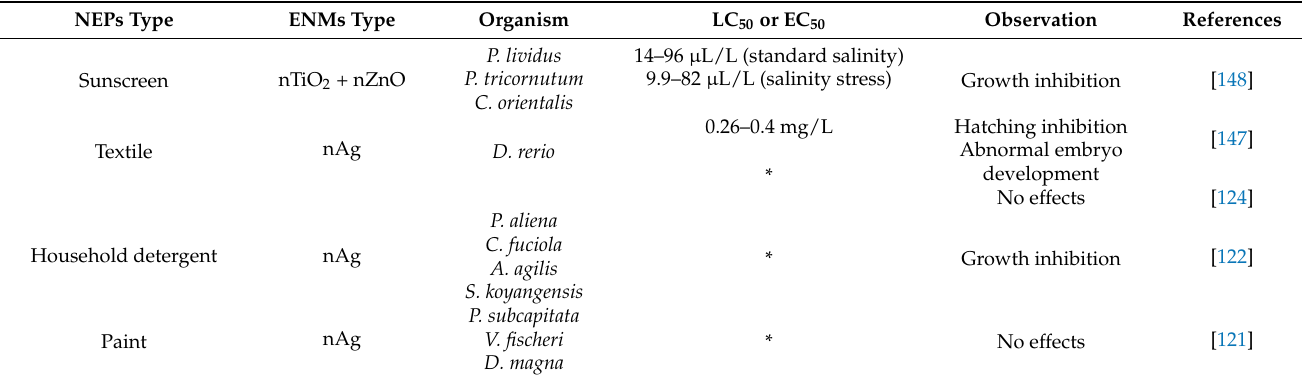
Table 3. The summary of reported on ecotoxicological data based on PR–ENMs 1 investigated, surrogate organisms observed effect and LC 50 2 or EC 50 3 where reported ( continuation